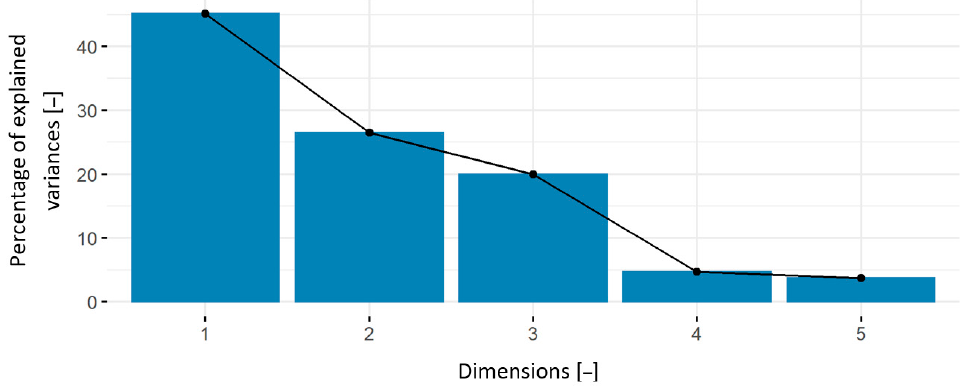
Figure 13. Scree plot.